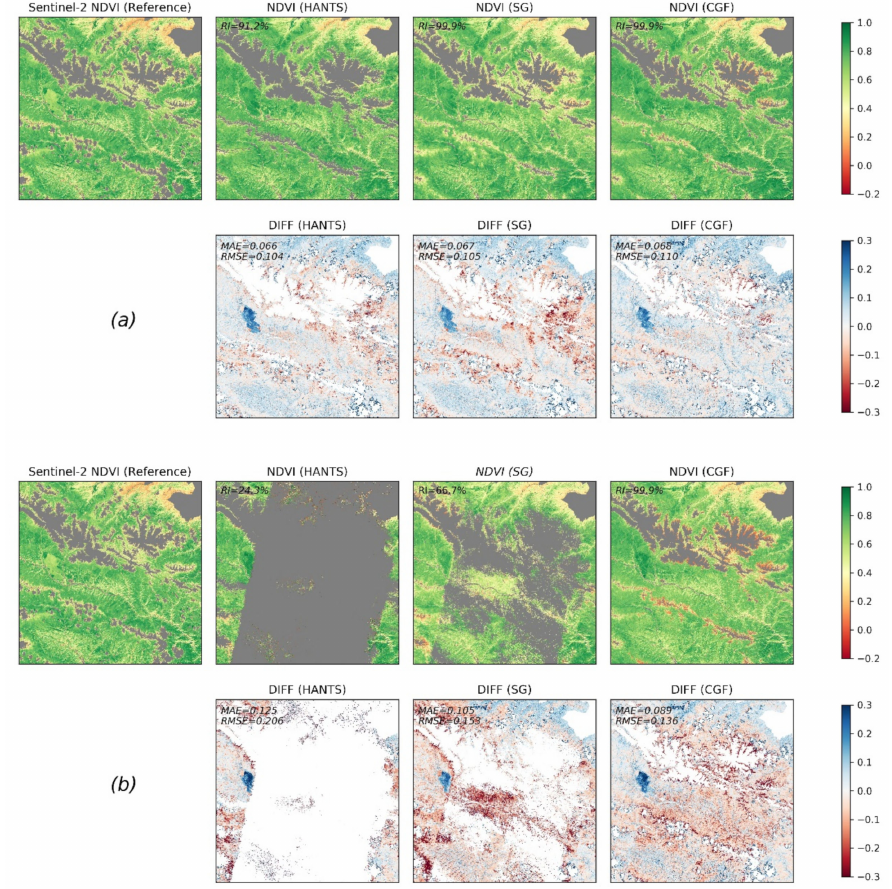
Figure 9. Comparison of reconstruction methods with Landsat observation data from 2017. ( a ) Re- construction results in DOY (day of year) 193 in 2017 with actual gap patterns. ( b ) Reconstruction results with gap patterns of Landsat composited NDVI in